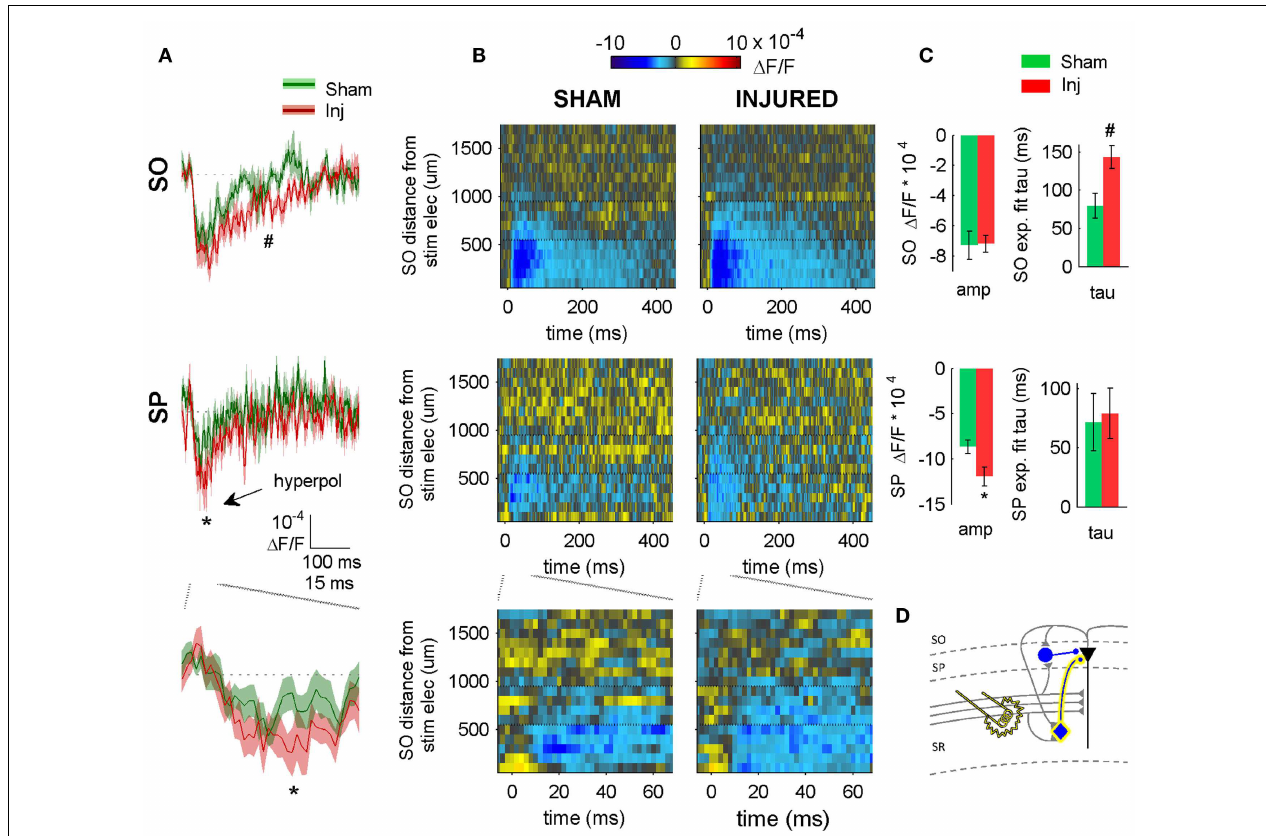
hyperpolarization. Horizontal dotted lines indicate raster region corresponding to multi-segment analysis region (segments 6–9). (C) Group statistics indicating significant differences in hyperpolarization amplitude and duration (latter measured as exponential fit time constant over falling phase of response, beginning at 40ms). (D) Schematic showing direct activation of CCK basket cell (yellow highlight around cell body and axon) by SR stimulation in APV and CNQX. Same legend as in Figure 1 . Stimulus: 300 µ A. Sham n = 11, injured n = 11. SO, stratum oriens; SP, stratum pyramidale; Inj, Injured; amp,